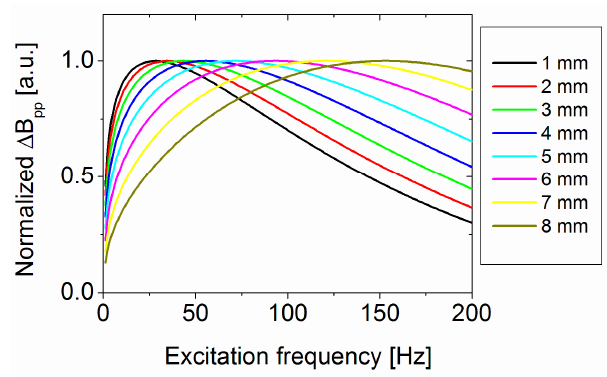
Figure 14. Normalized peak-to-peak change in magnetic field amplitude versus frequency for defects with increasing defect depth using Formula (6).